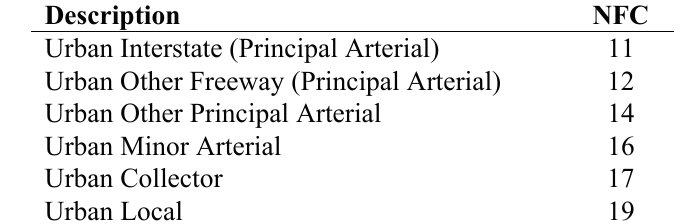
Table 1. National functional class roadway descriptions for urban